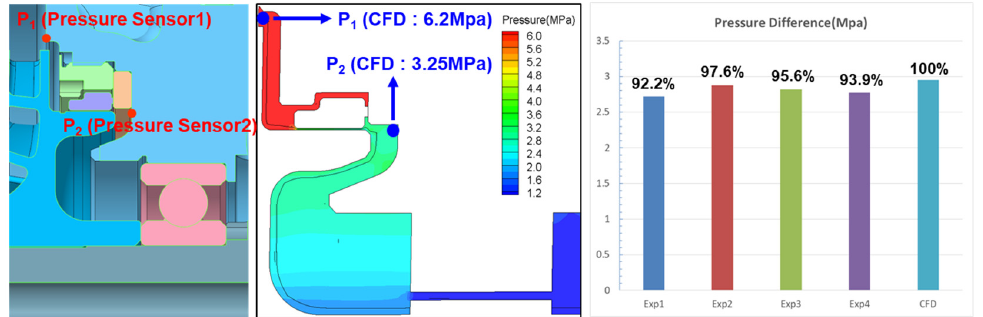
Figure 6. Position of pressure sensors in LOx pump and comparison of pressure difference measured by CFD and EXP.